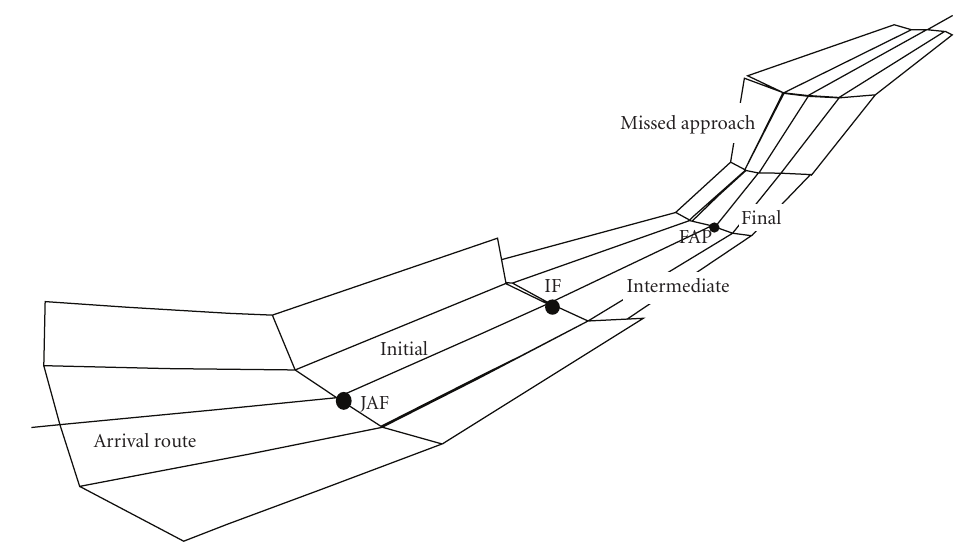
Figure 3: Instrumental approach segments [13].